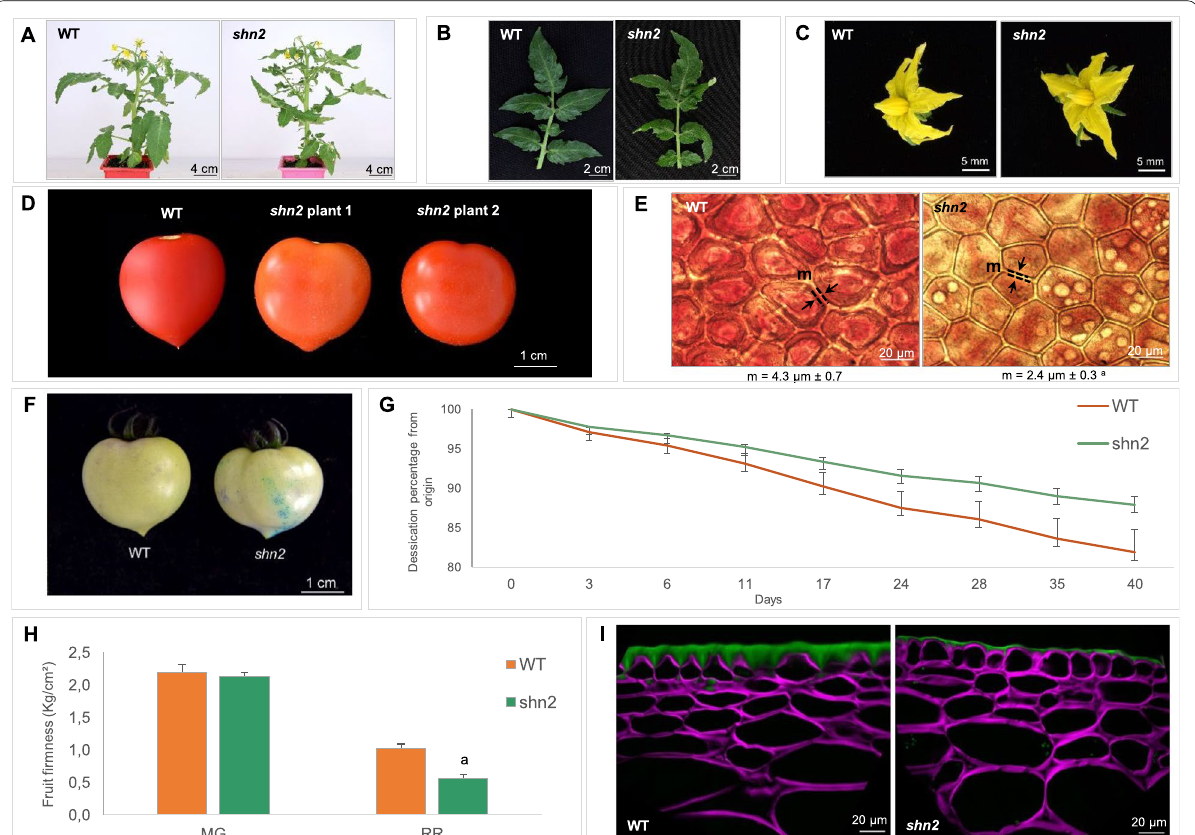
Fig. 4 Comparison of the developmental, cuticle and epidermal phenotypes of shn2 mutant and wild-type (WT). A - C The shn2 mutation has no effect on the architecture of 6 weeks-old plants ( A ) and on the morphology of the fourth leaf ( B ) and flower at anthesis ( C ). D Variability in fruit colour and glossiness of shn2 fruits. E Microscopic observations of freshly peeled outer epidermis of red ripe (RR) fruit. The white bodies within the cells are likely oil bodies. The width of the cutinized cell wall was measured between the two black arrowheads (m). Mean values (in µm) of 100 measures (10 measures on 10 sections) are given with SD. a, P < 0.01 (Student’s t test). F Macroscopic observations of cuticle permeability of mature green (MG) fruits after overnight soaking in 0.1% toluidine blue. G Water loss progression in RR fruit was measured over 40 d of postharvest storage at room temperature. ( n 5). H Fruit firmness of MG and RR fruits. Values are mean SD of 3 measures on 6 fruits. a, P < 0.01 (Student’s t test). I = ± Confocal fluorescence microscopy of exocarp cell layers using Calcofluor and Bodipy dual staining showing reduced cuticle deposition and loss of conical epidermal cell shape in the shn2 fruit. Scale bars are indicated on each pictures. MG, mature green; RR, red